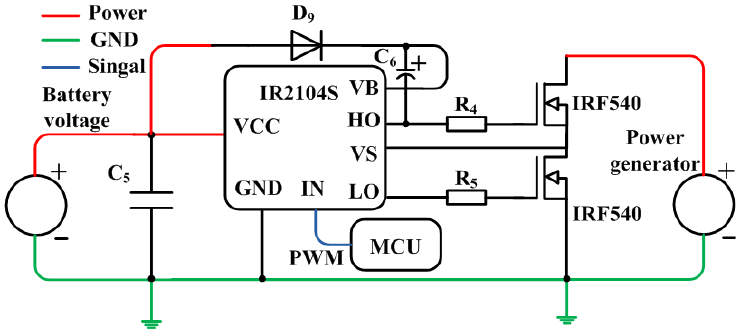
Figure 11. Schematic of the driver circuit.